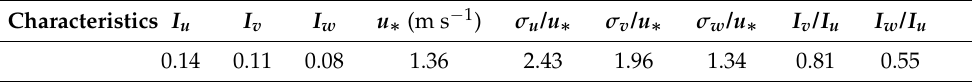
Table 1. Second-order integral turbulence characteristics recorded at 49 m above ground on MW1 (Bjørnafjord) on 8 December 2017 from from 2:00 a.m. to 5:00 a.m. Characteristics I u